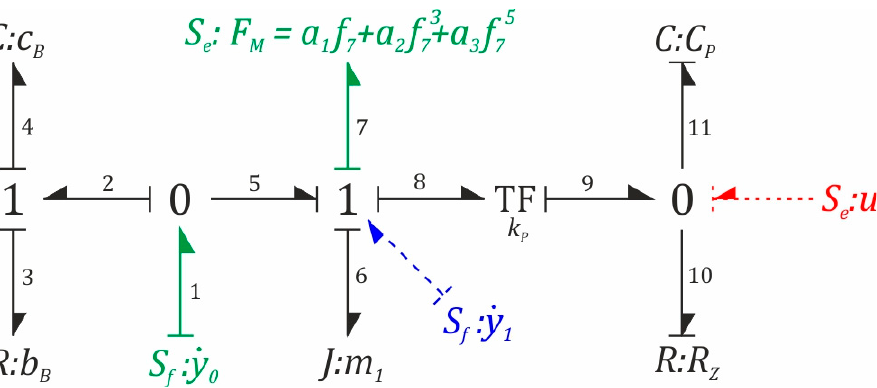
Figure 3. A Lagrange bond graph, with causality conflicts intentionally introduced.